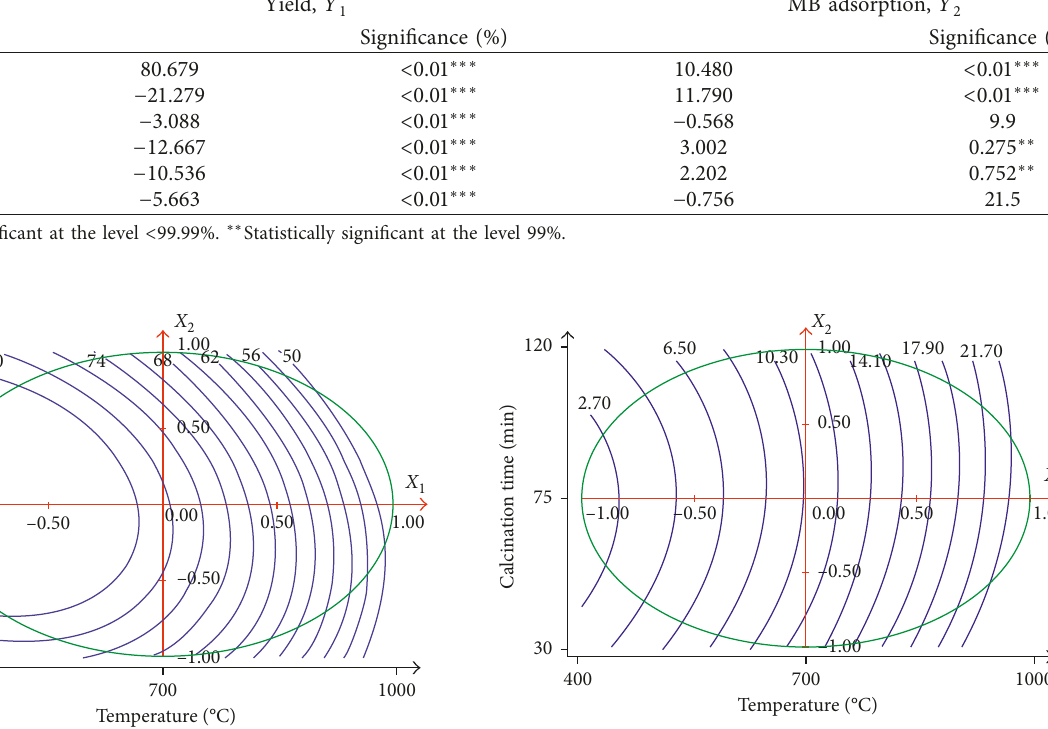
, %) as a function of calcination 1